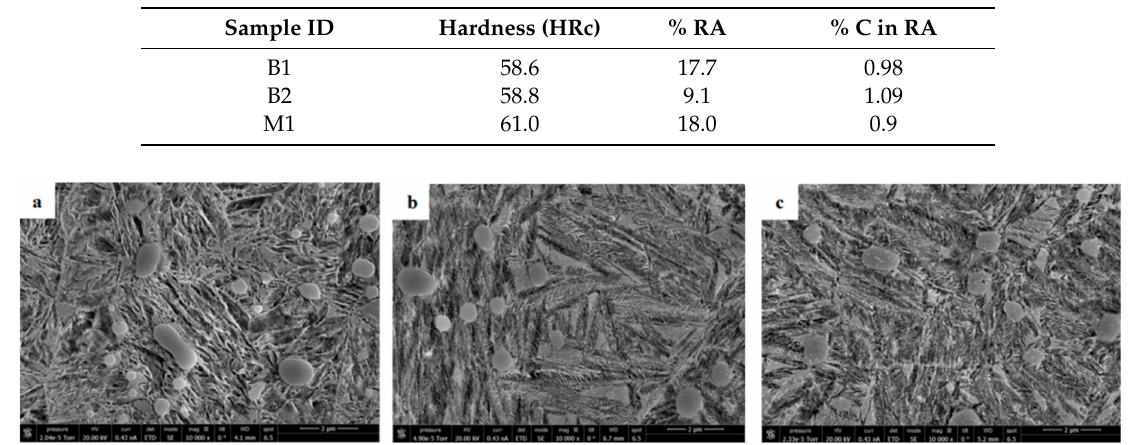
Figure 1. Scanning Electron Microscopy (SEM) Images of ( a ) M1 (martensitic), reproduced from [28], with permission of Elsevier 2018, ( b ) B1 (bainitic with 2 h soak), and ( c ) B2 (bainitic with 4 h soak)